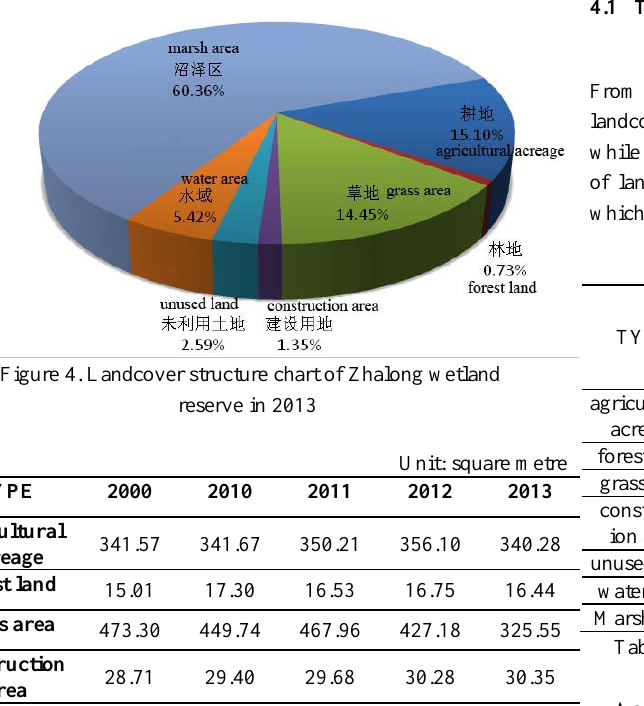
Table 3. Landcover variation of Zhalong wetland reserve According to the five years statistics results (2000,